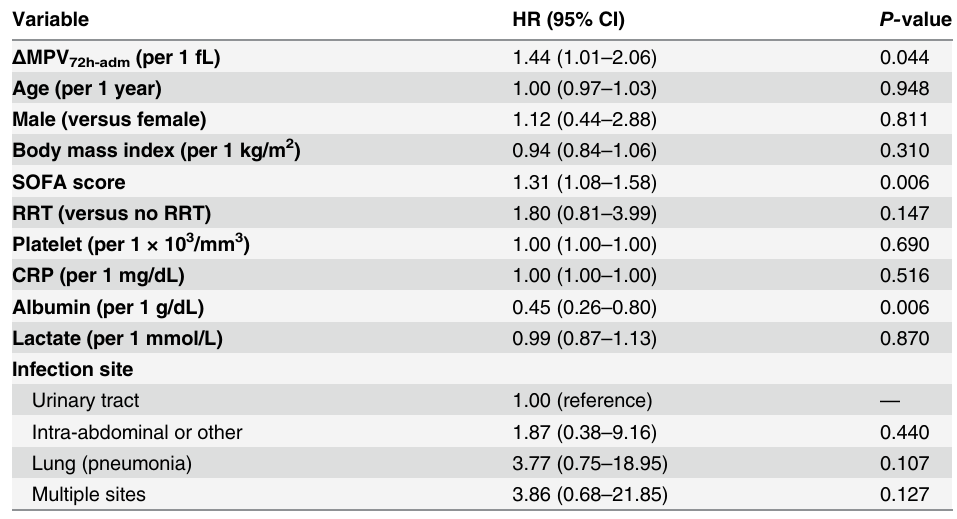
Table 6. Multivariate Cox proportional hazards analysis for 28-day all-cause mortality (Model 2).